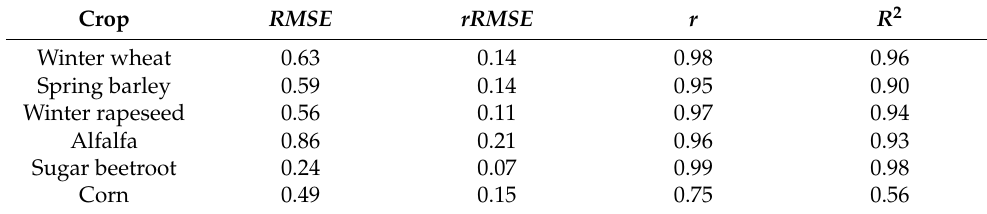
Table 4. Comparison of Landsat and Sentinel LAI estimations using RMSE , rRMSE , r , and R 2 statistics.